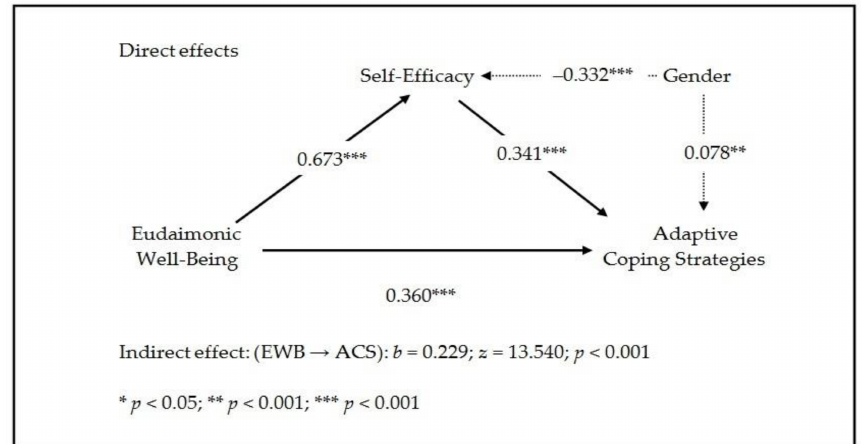
Figure 3. Graphical representation of the results of the mediation model [Gender (Male = 1; Female =